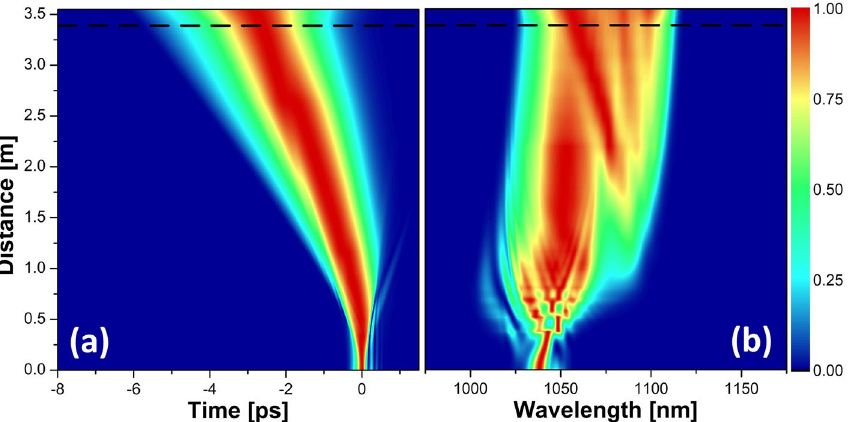
Figure 4. Evolutions of the normalized temporal ( a ) and spectral ( b ) intensities at the highest pump power for the high-repetition-rate laser as a seed source. The dashed black line shows the splice between the active and the passive